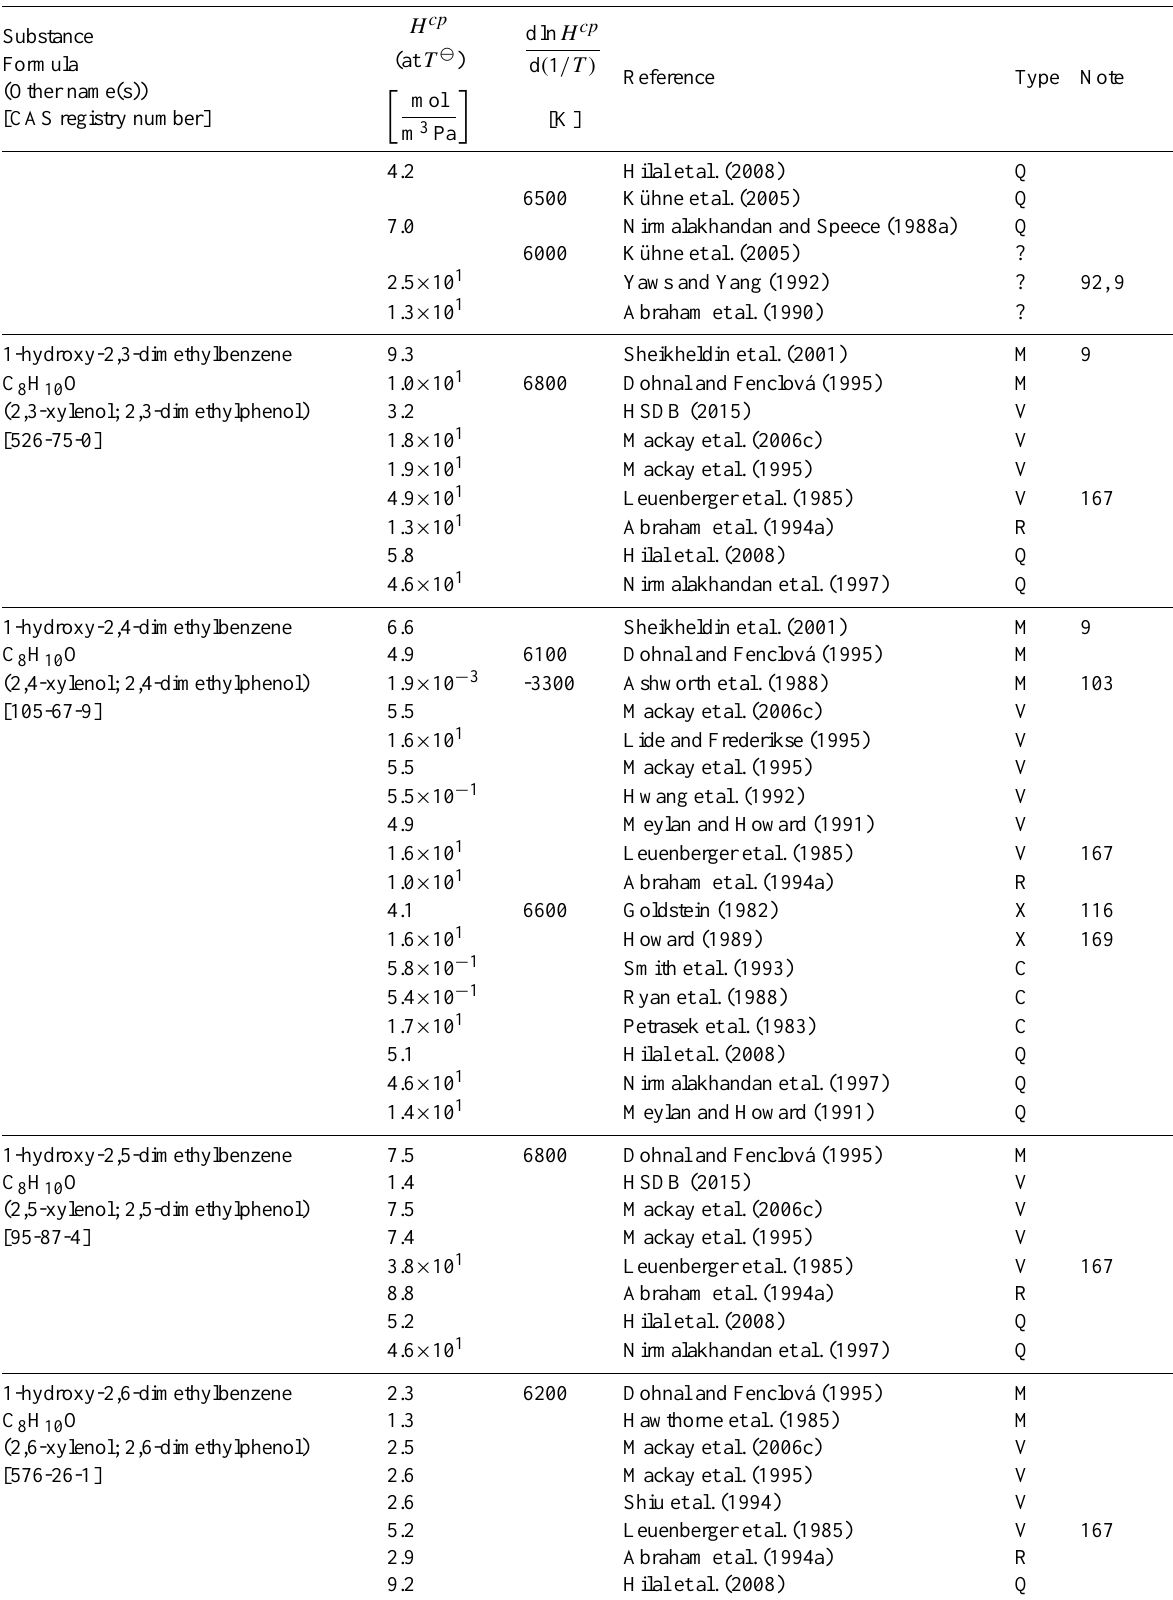
Table 6: Henry’s law constants for water as solvent